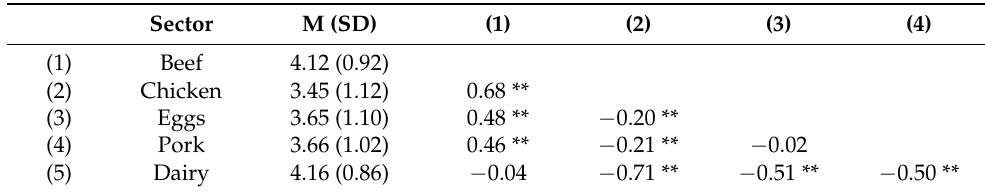
Table 4. Summary of mean difference in consumer perception of farm animal welfare across five production